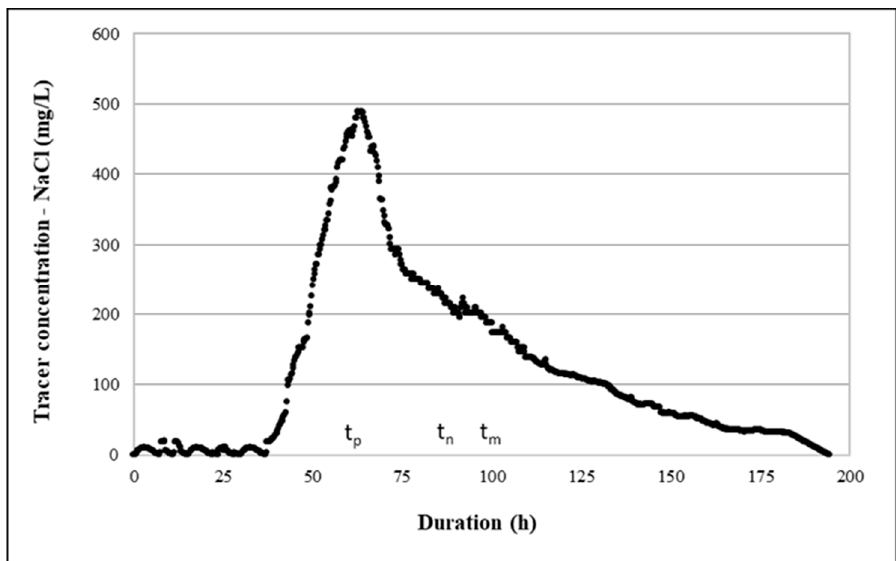
Figure 5. Tracer (NaCl) concentration at the HSTW outlet during the tracer test experiment.